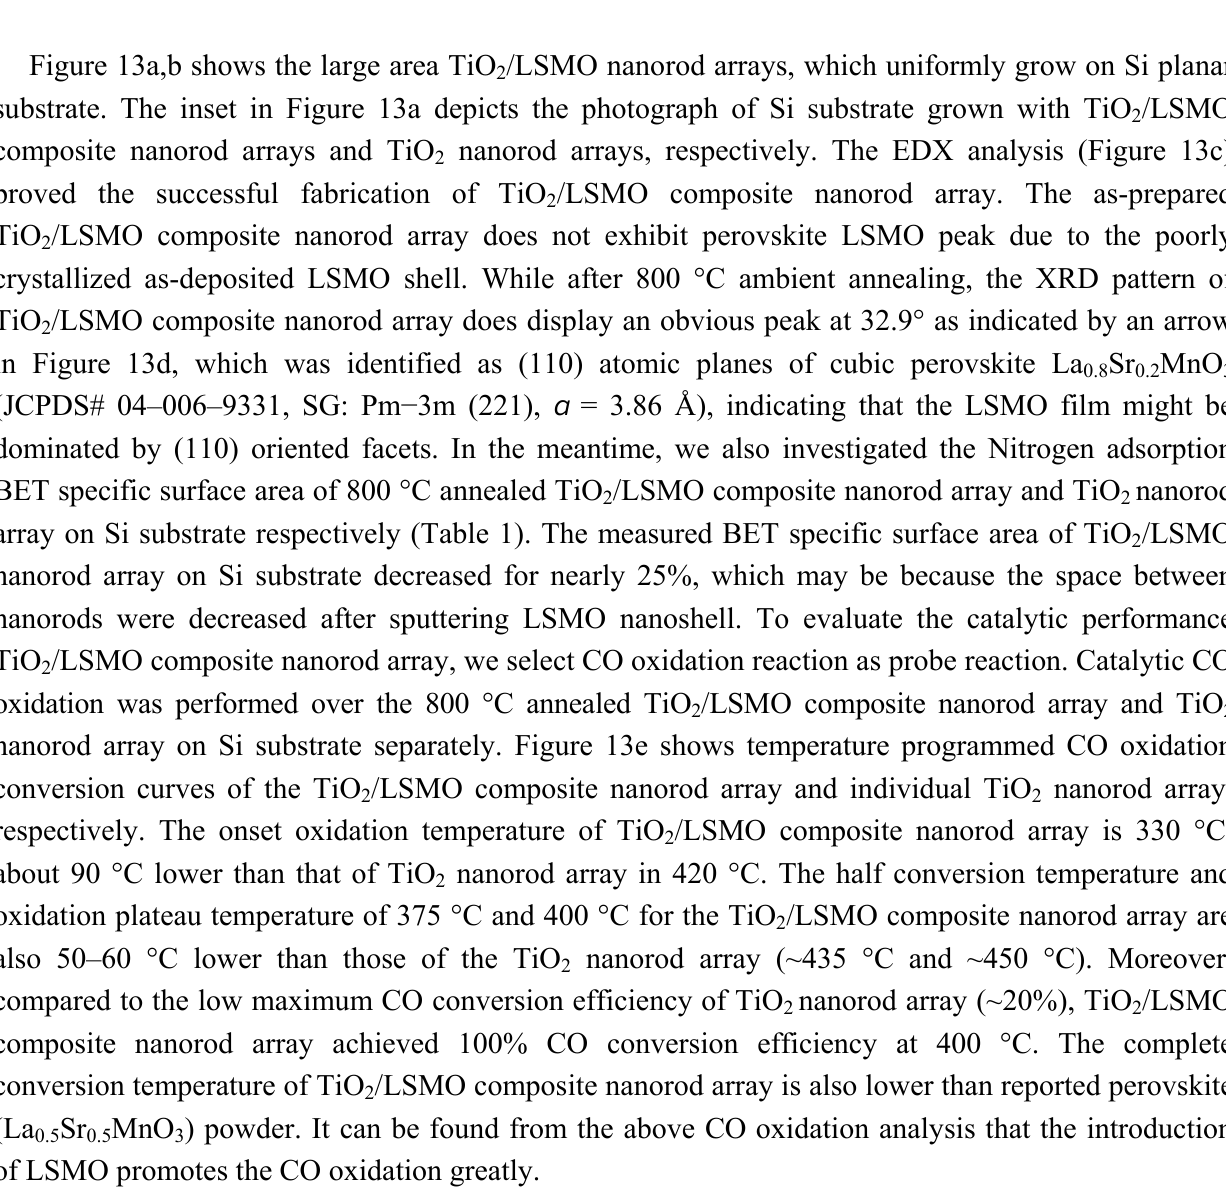
nanorod array 2